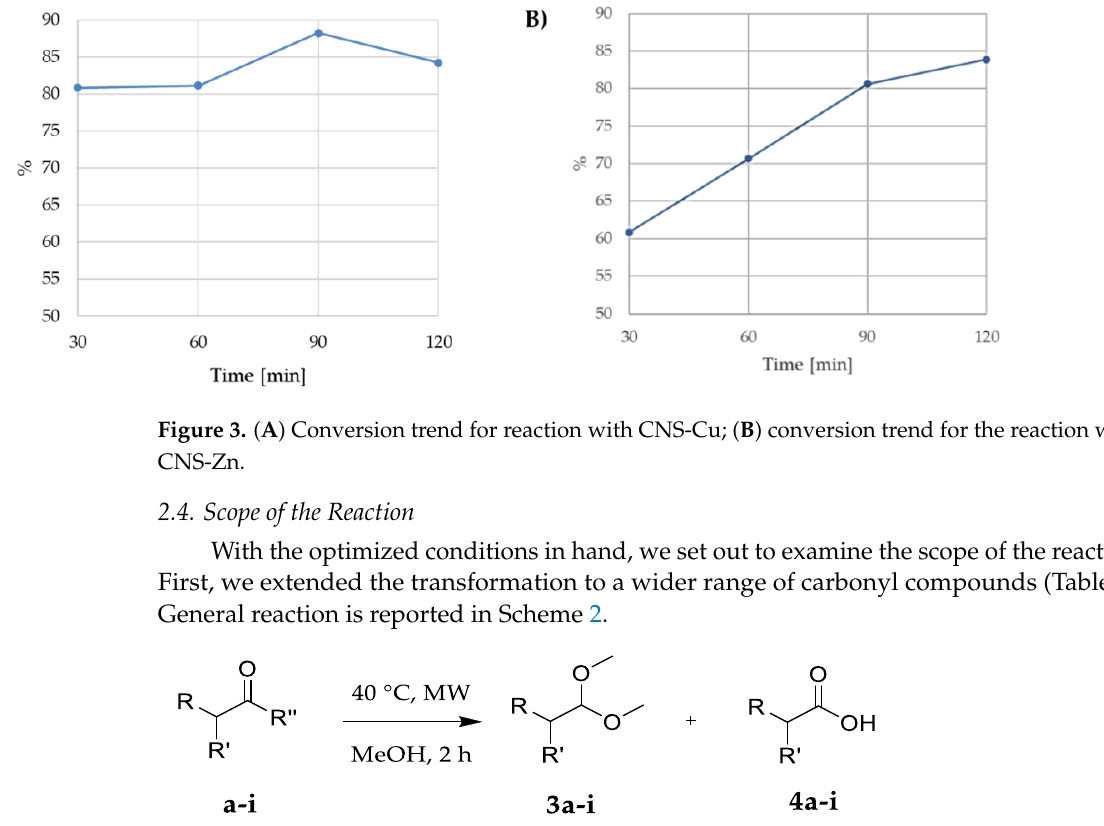
Scheme 2. General reaction scheme for the formation of the acetal and the acid product in Table 7. Reactions with different carbonyl compounds using methanol as solvent *.